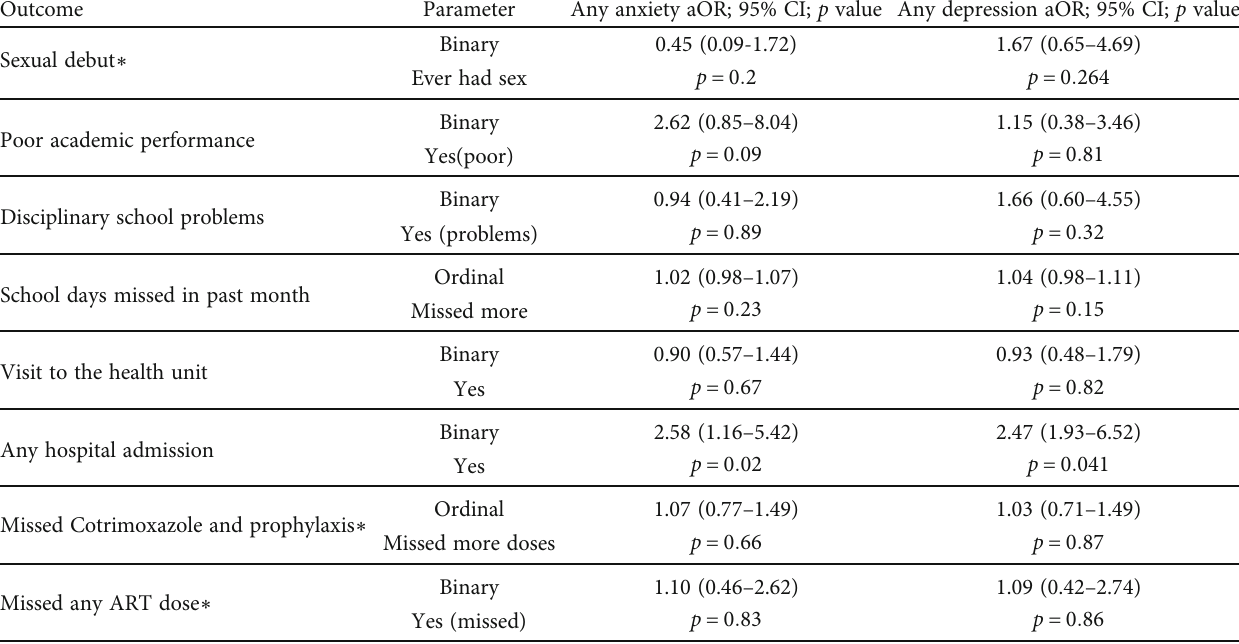
Table 5: Outcomes associated with “ anxiety and depressive disorders ”